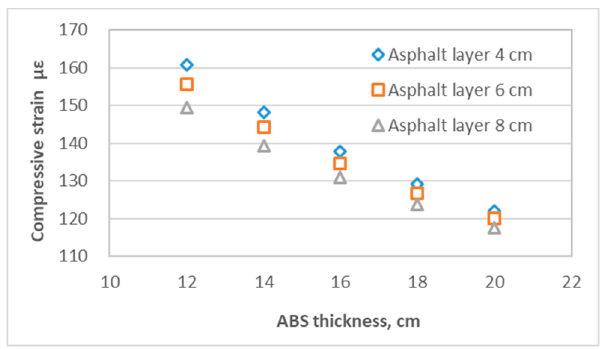
Figure 9. Influence of asphalt mixture layer and ABS layer thickness on the vertical compressive strain at subgrade (the thickness of the steel plate layer is fixed at 0.6 cm).